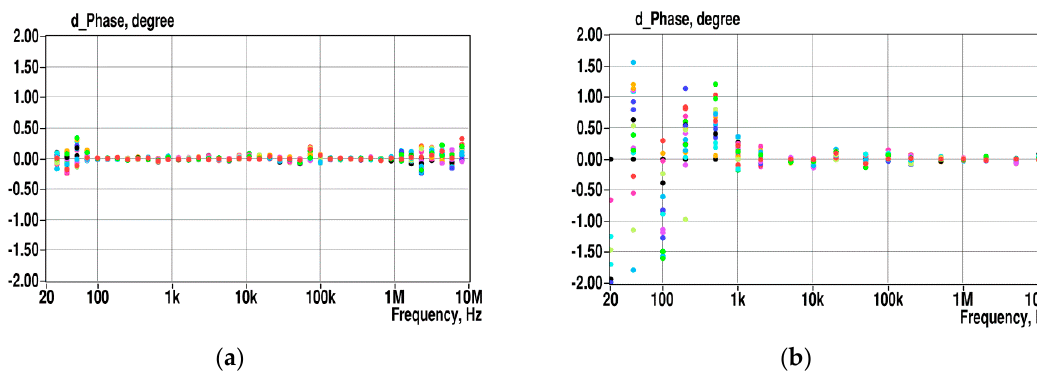
Figure A7. Impedance phase variations of the SUT1 measured with the Wayne Kerr analyzer ( a ) and the developed analyzer ( b ).